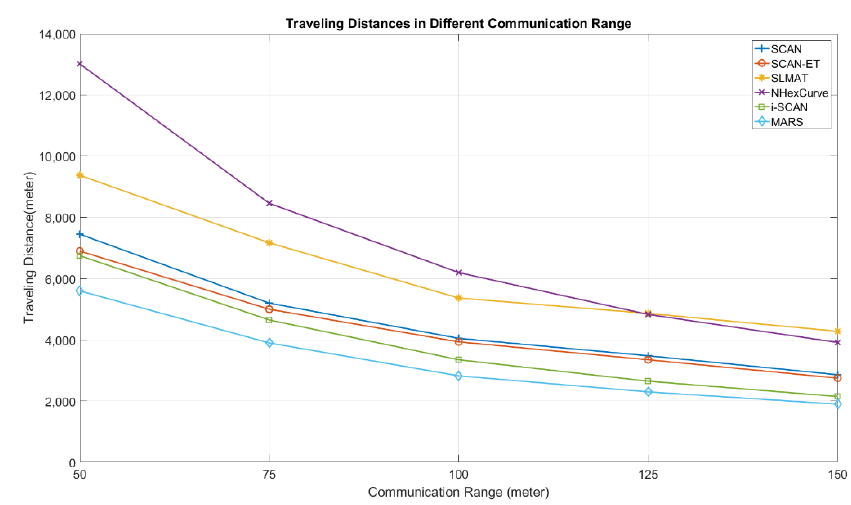
Figure 6. Traveling distances with different communication ranges (40 nodes).